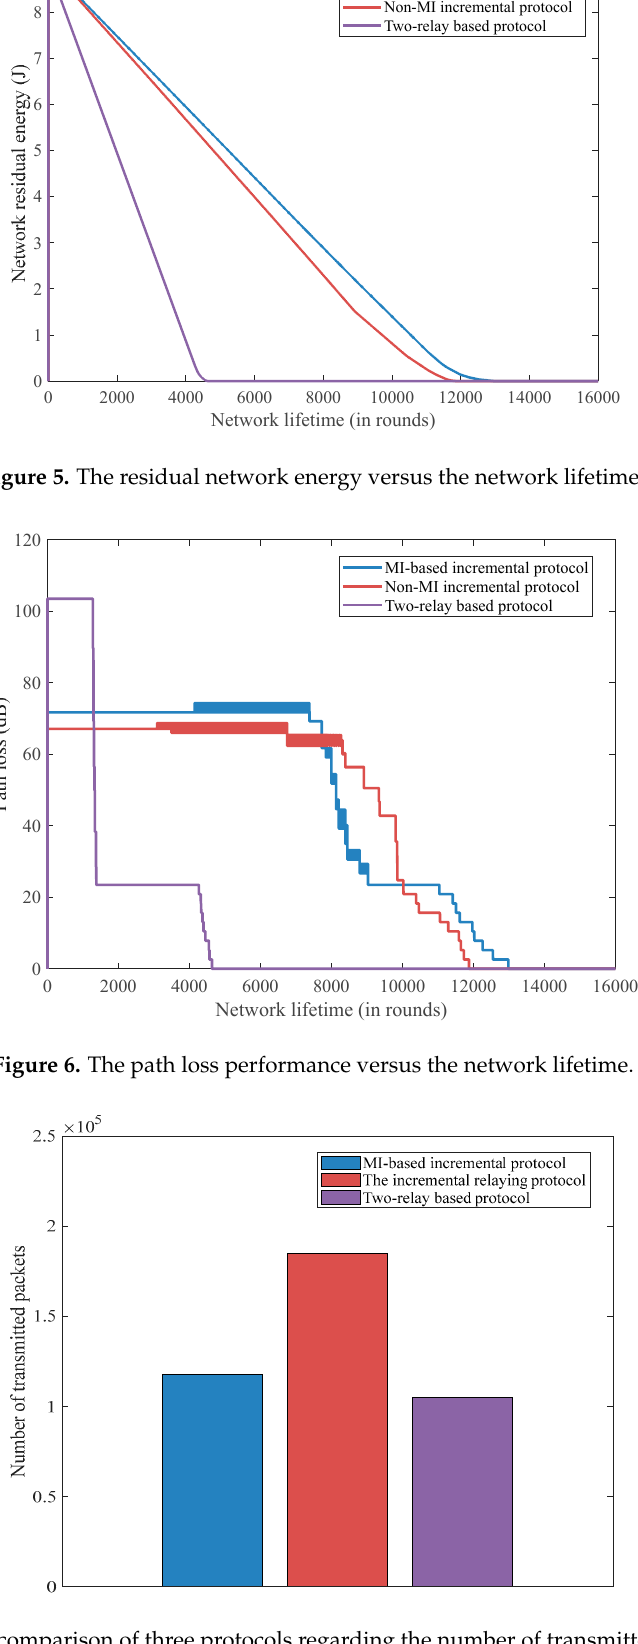
Figure 7. A comparison of three protocols regarding the number of transmitted packets.